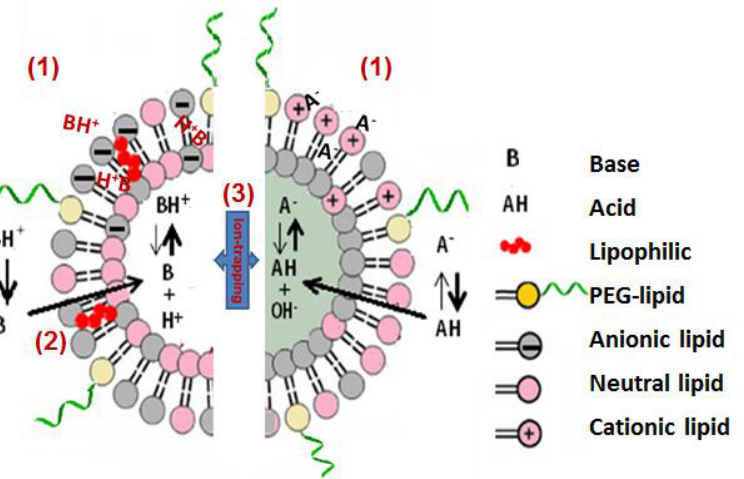
Figure 1. Mechanisms by which liposomes interact with drugs of varied physicochemical properties: ( 1 ) electrostatic interactions, ( 2 ) lipid-lipid interaction, and ( 3 ) ion-trapping of lipophilic weak bases or acids driven by transmembrane pH-gradients. Reproduced with permission from Ref. [11]. Copyright 2018 Elsevier Inc. Cambridge, MA, USA.